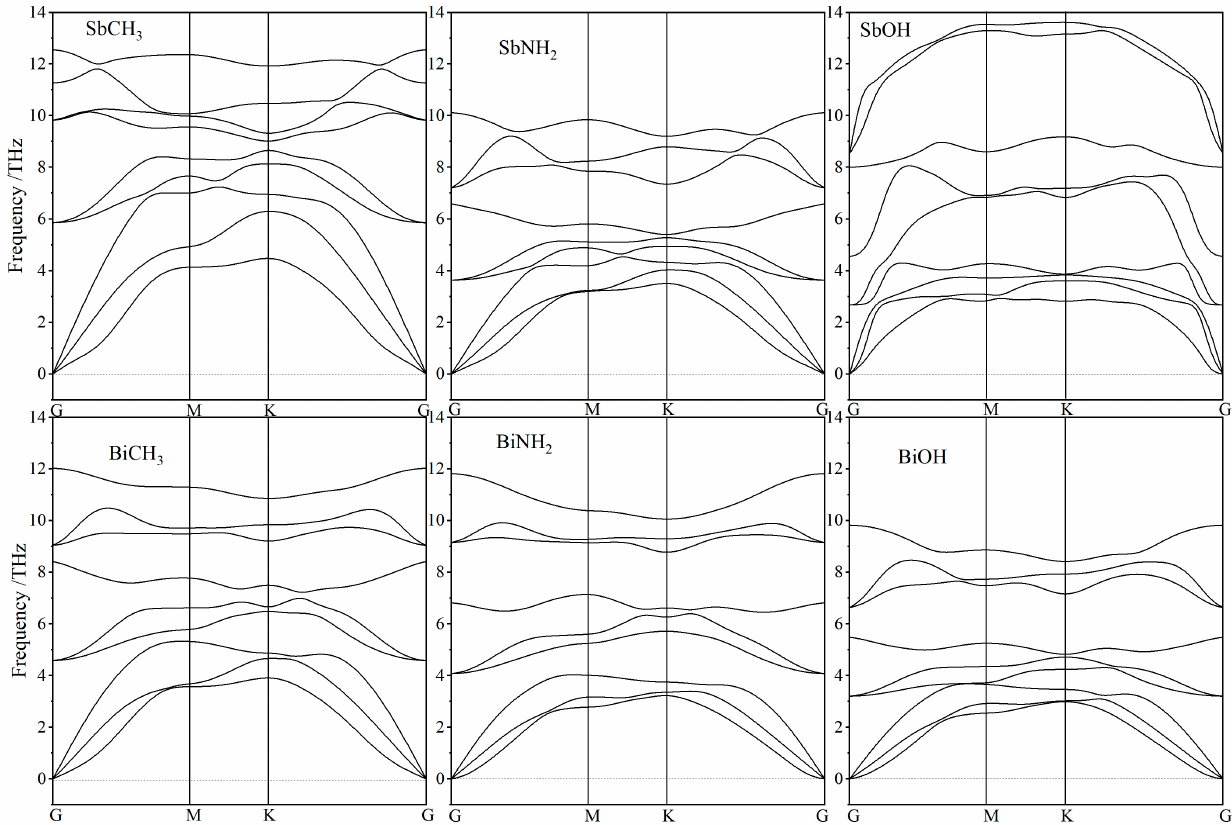
Figure 2. Phonon frequency dispersion spectra of SbXH n and BiXH n in atom-relaxed structures.